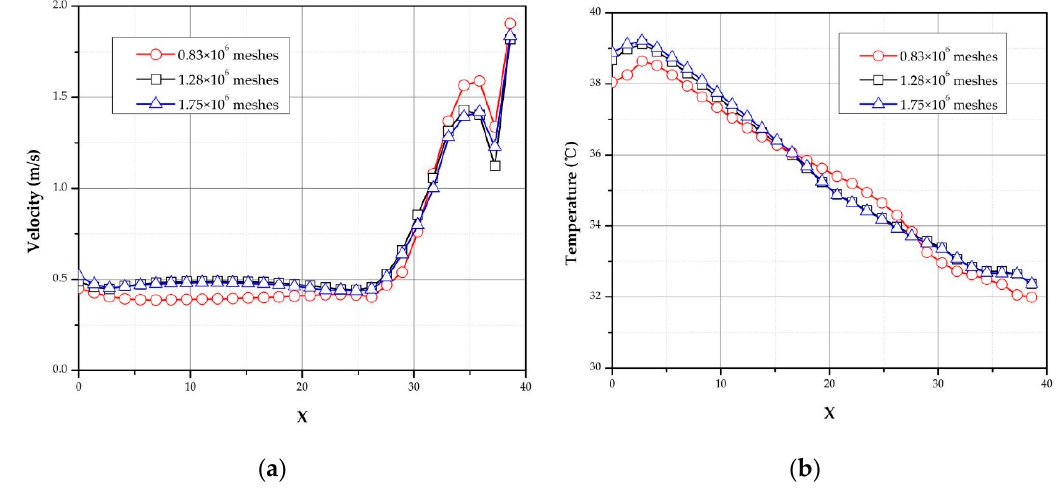
Figure 9. Comparison with the original mesh ( a ) and first adaptive mesh ( b ).